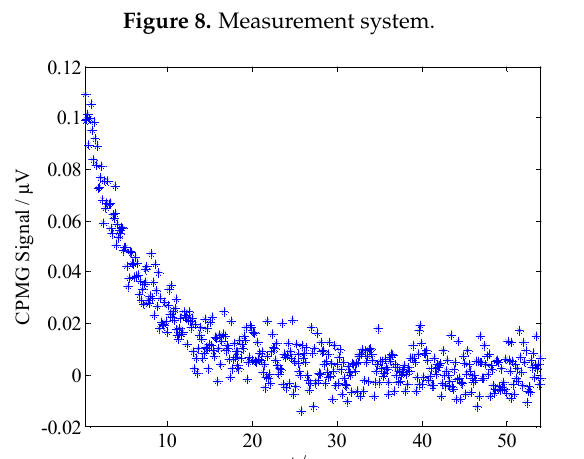
Figure 9. T 2 decay measured using a CPMG sequence for sample A (moisture content is 8.53%).